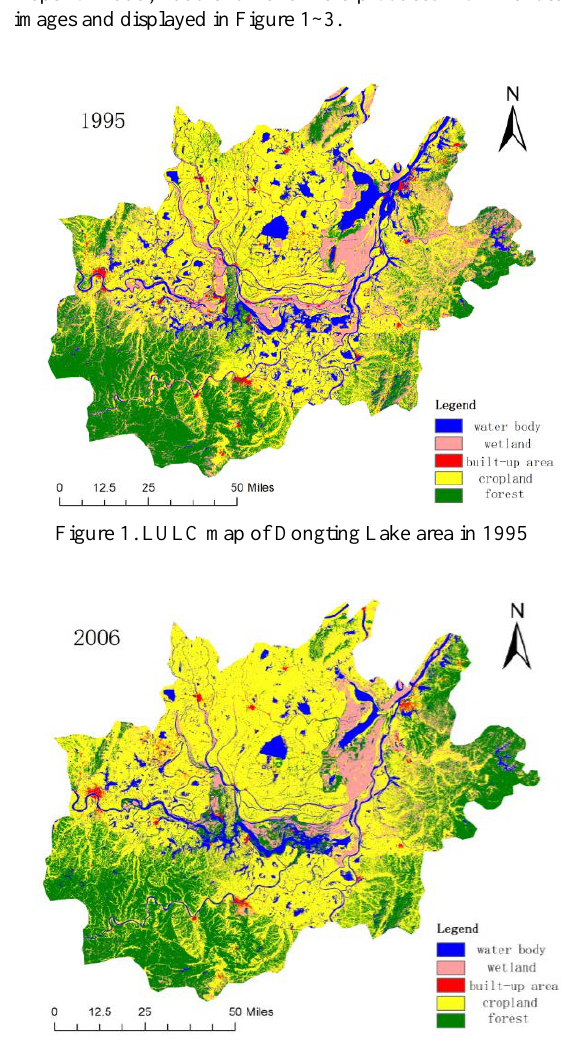
Figure 2. LULC map of Dongting Lake area in 2006